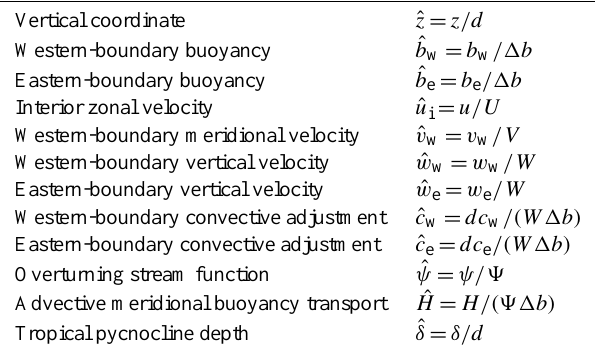
Table 1. Definitions of nondimensional